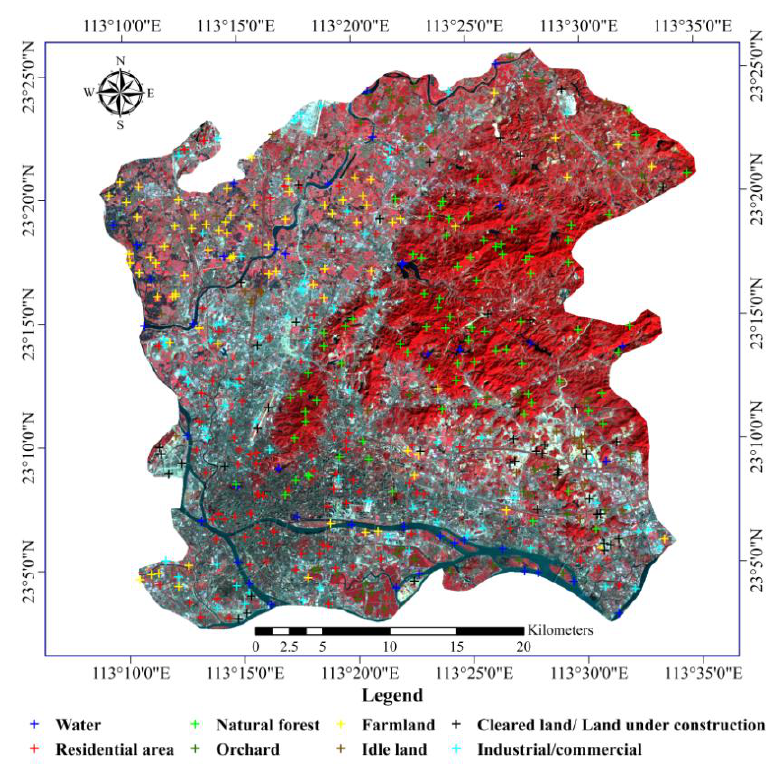
Figure 2. The distribution of test